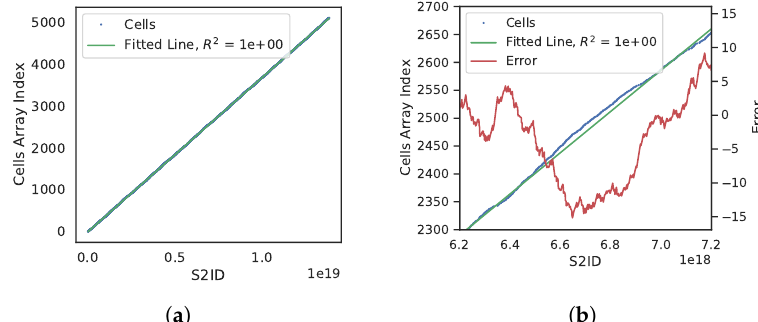
Figure 11. Linear prediction model for a level four Gaussian Accumulator (GA). The 5120 GA cells are sorted in an array ( Cells ) by their corresponding spatial index s 2 id ; ( a ) Plot relating cell s 2 id and index position in the Cells array with a regressed line (green) to the data; ( b ) Zoomed-in view showing model error (red line) indicating difference between predicted and actual index for each s 2 id